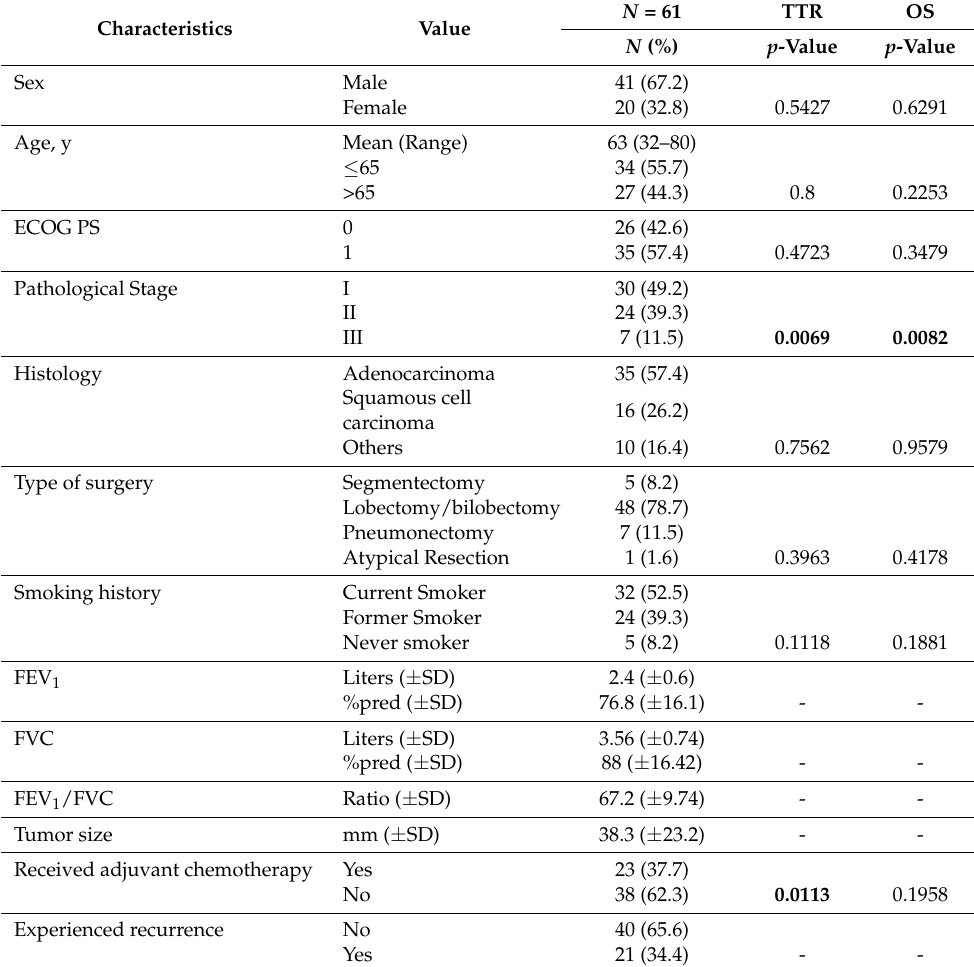
Table 1. Main clinical characteristics of the patients and univariate p -values (log-rank test) for time to relapse (TTR) and overall survival